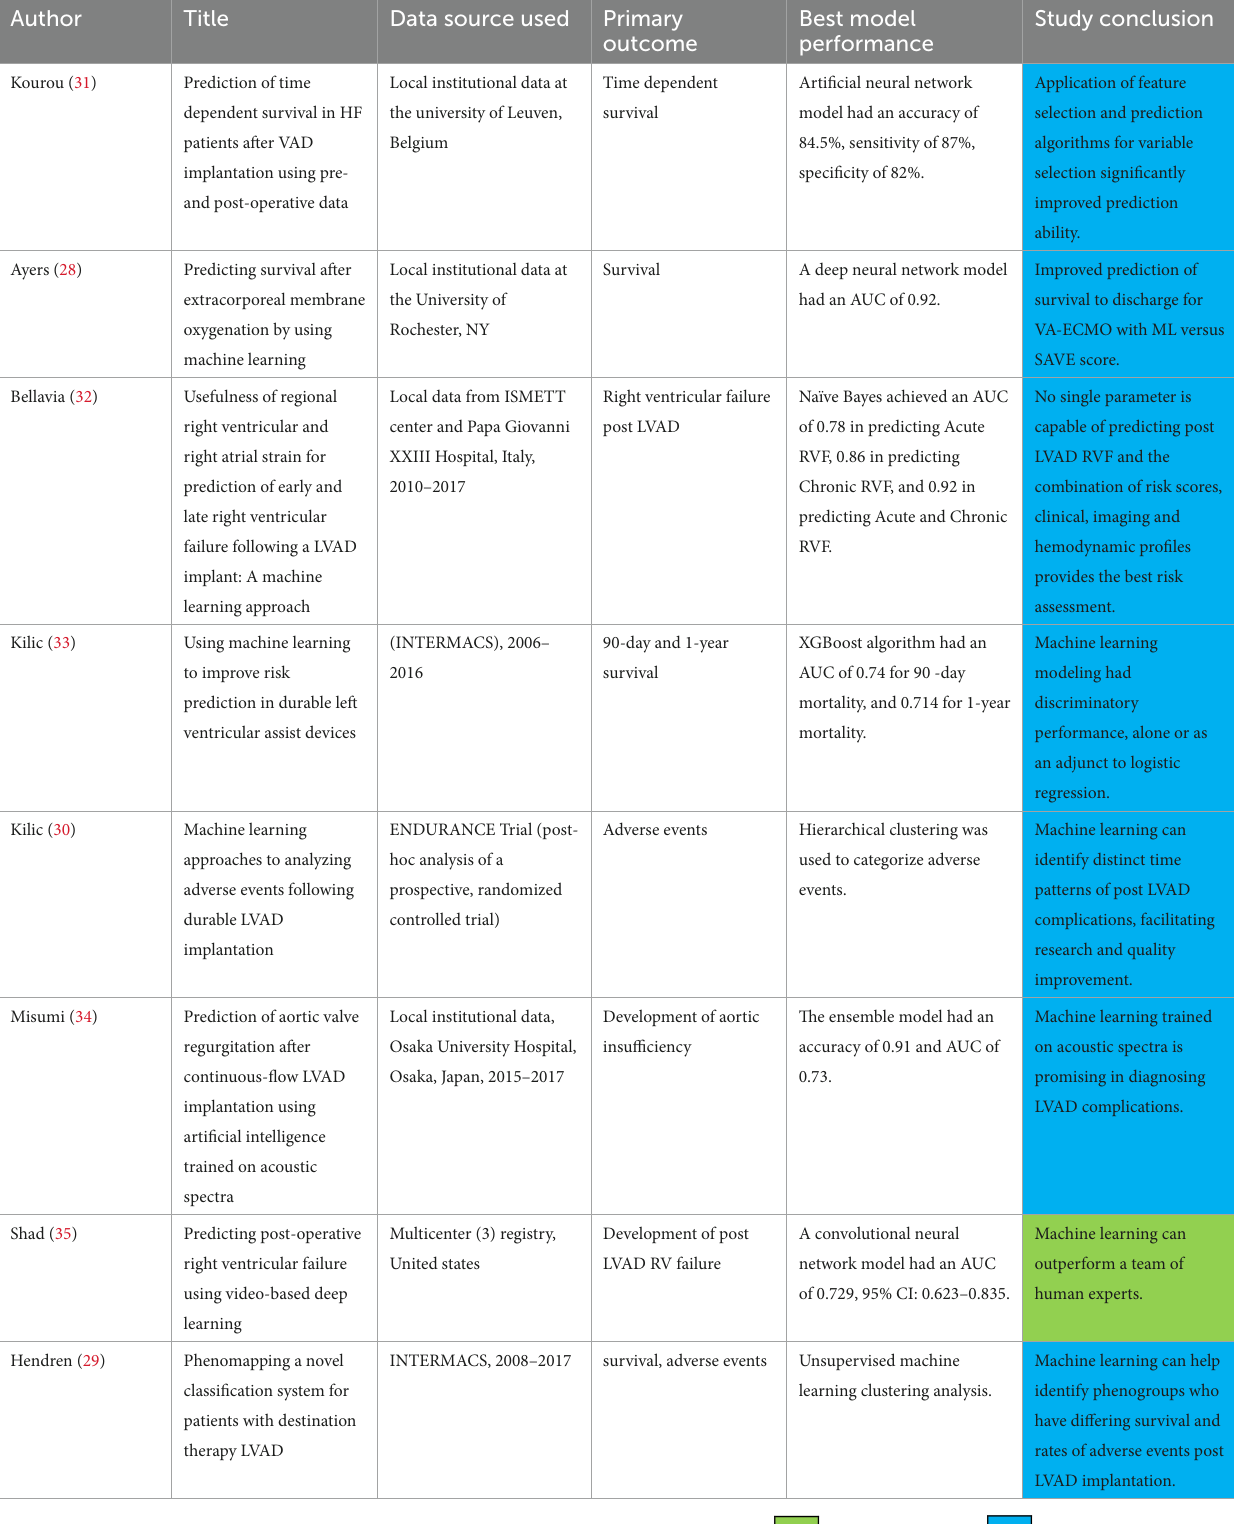
TABLE 3 Summary of publications describing artificial intelligence application in predicting mechanical circulatory support